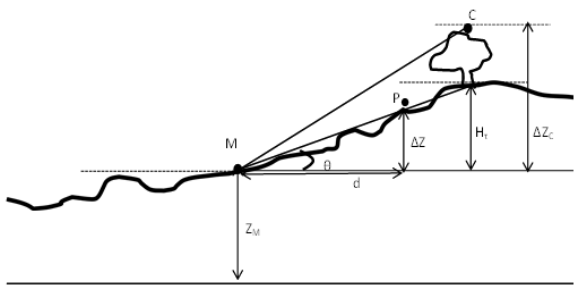
Figure 2 Sketches of ground and off-ground points together with the threshold height and the actual elevation difference in relation to the reference surface The threshold elevation difference ( H τ ) can be derived from Equation (2) by adding an adjustment term ( h ) to account for the random error σ ξ and/or the local undulations (Equation (7)). Ground points have an elevation difference (∆ Z ) less than or equal to the H τ as in the case of point P while off-ground points, for example point C in Figure 2, have ∆ Z greater than H τ